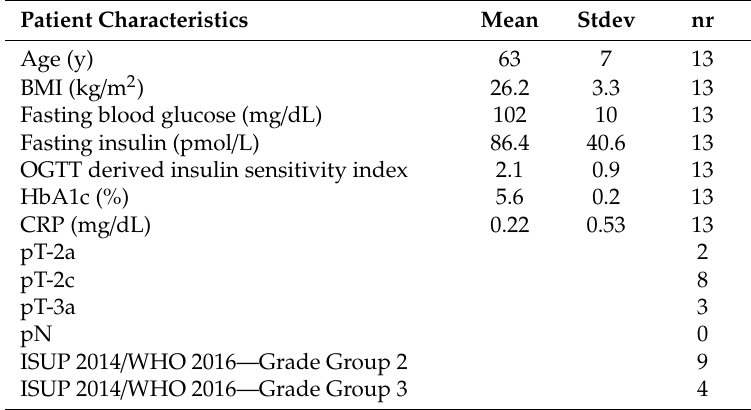
Table 1. Patient characteristics—mass spectrometry cohort.